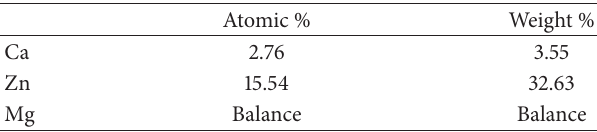
Table 3: Elemental composition of Mg-35Zn-3Ca alloy assessed by energy dispersive X-ray analysis. Atomic % Weight %